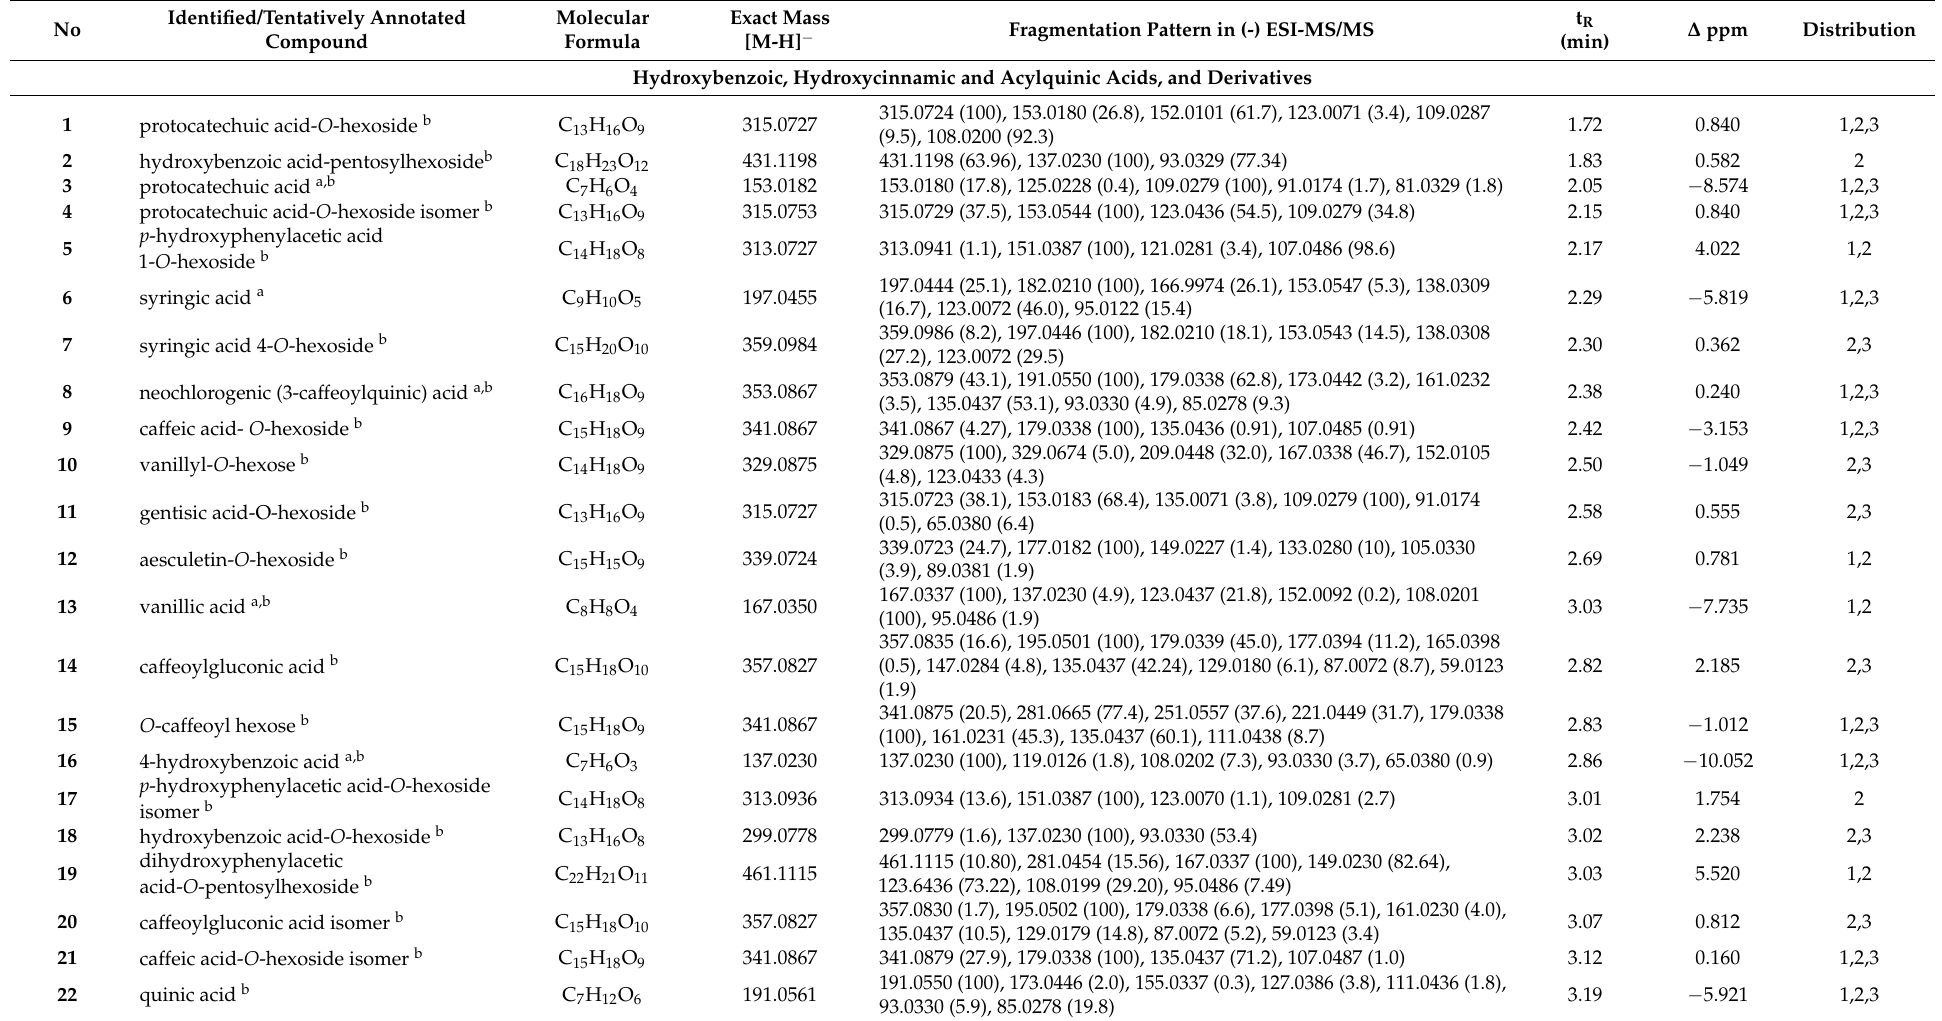
Table 2. Secondary metabolites in Tanacetum balsamita extracts assayed by